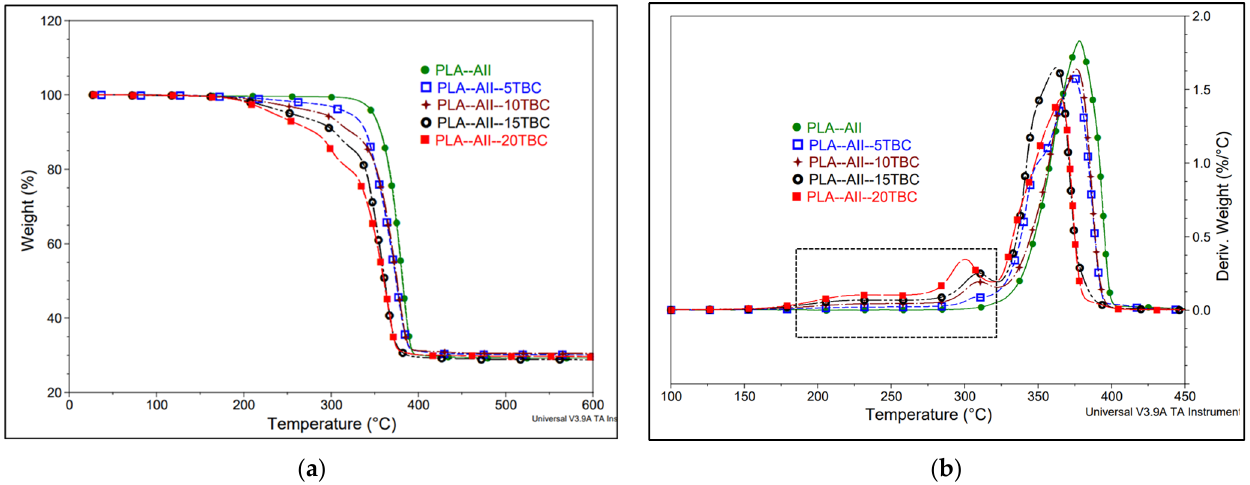
Figure 7. ( a , b ) TG ( a ) and DTG ( b ) curves of plasticized compositions compared to the composite without plasticizer (PLA–AII) (under air, rate of heating of 20 °C/min). Table 5. Comparative thermal parameters as determined by TGA (under air, 20 °C/min) for PLA–AII composites with/without plasticizer.